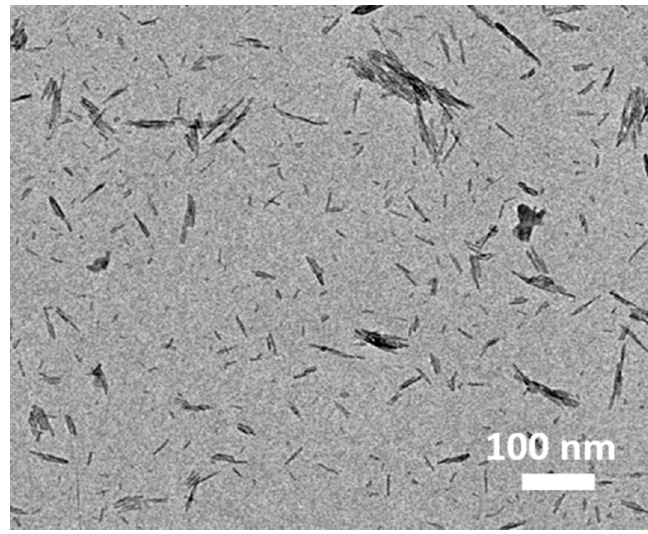
Figure 4. TEM image of the pure PEDOT fibers.